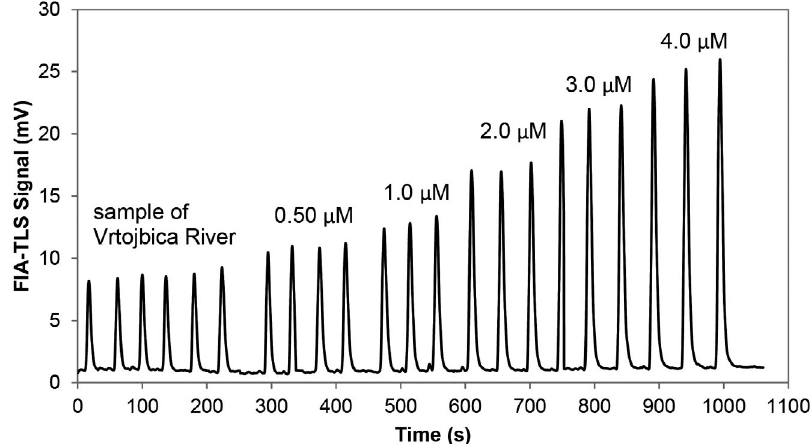
Figure 10. The TLS signal peaks of Vrtojbica creek with added proper amount of Fe(III) and 1 mM PHN as carrier solution